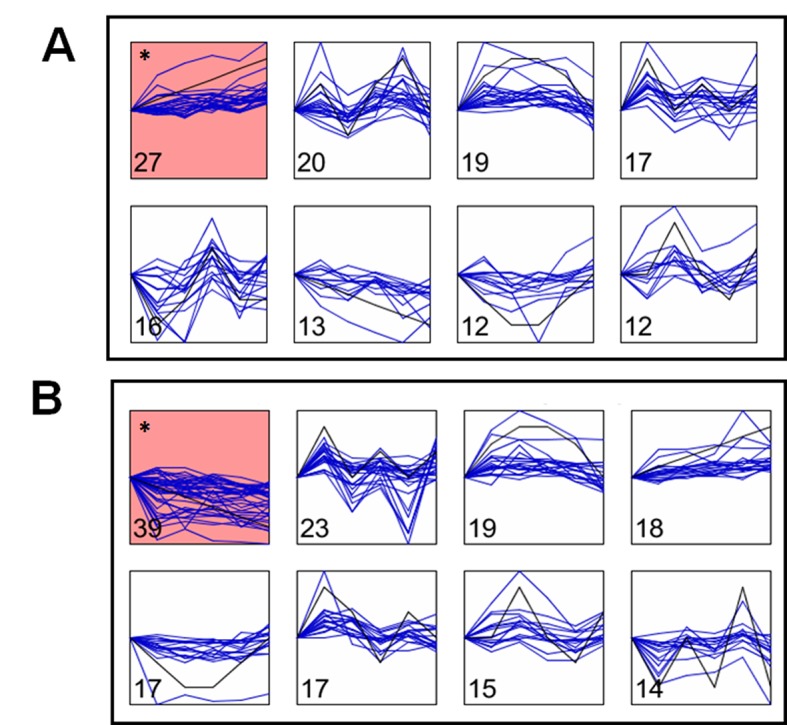
STEM analysis showing metabolite accumulation patterns across the time-course of HCO3
- treatment of (A) MC and (B) GC.Numbers at the bottom-left indicate the metabolites with similar trends, and the star indicates significance (P < 0.05).